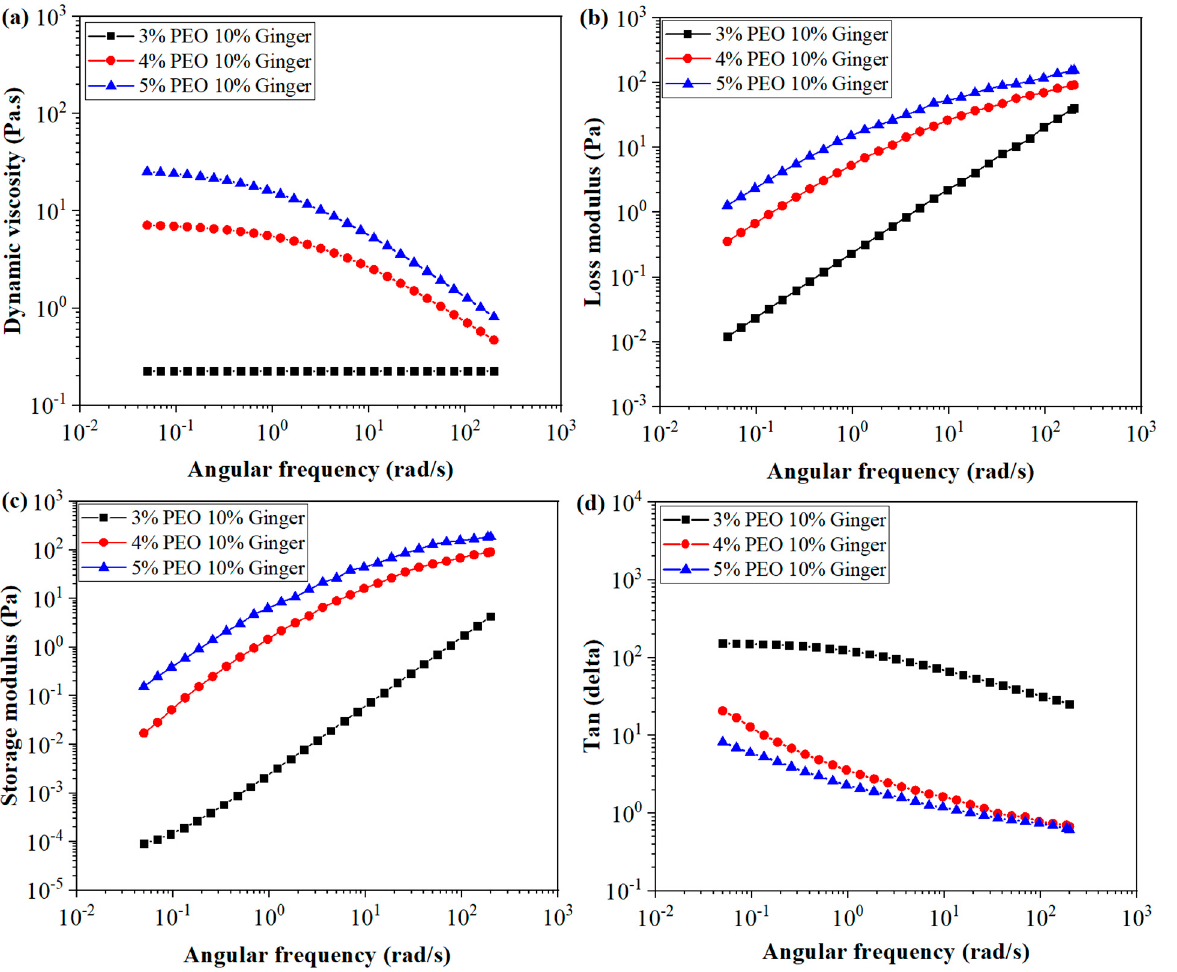
Figure 5. ( a ) Dynamic viscosity, ( b ) Loss modulus, ( c ) Storage modulus, and ( d ) Tangent delta of PEO/GE nanofibres (PEO 3%, 4%, 5% GE 10 % ). PEO/GE nanofibres (PEO 3%, 4%, 5% GE 10%